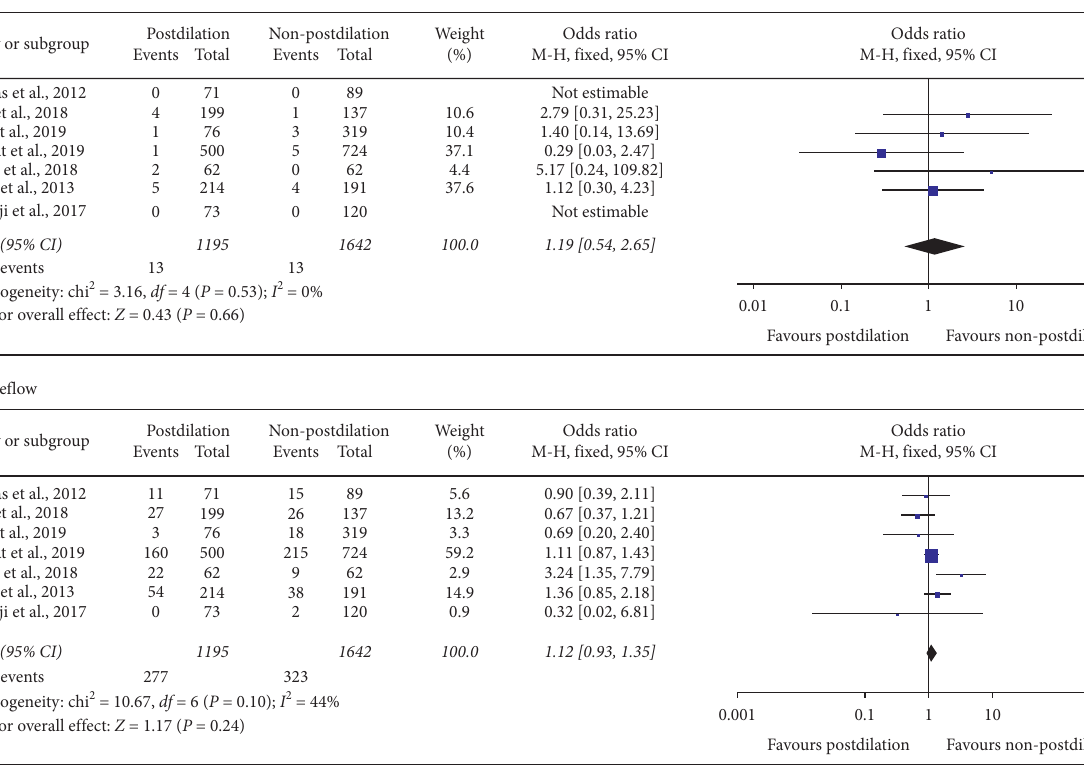
Figure 4: Forest plots of angiographic outcomes between postdilation and non-postdilation